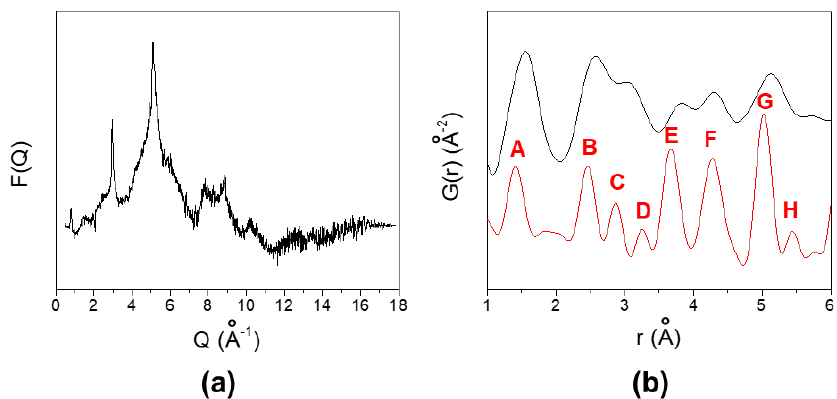
Figure 4. ( a ) F(Q) function; ( b ) experimental G(r) of GO sample (black line) and calculated G(r) of graphite (red line). For the meaning of A–H labels, see Reference [22].